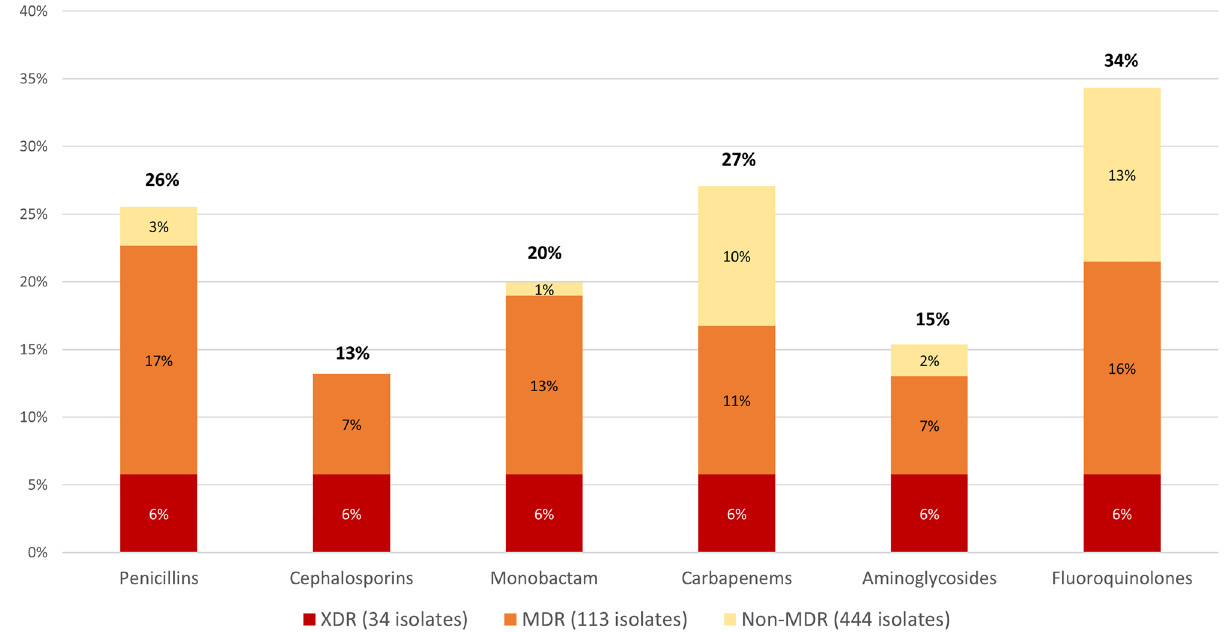
Figure 1. Overall resistance rates of the 591 P. aeruginosa urinary isolates to antimicrobial groups. Overall resistance rates are presented for each antimicrobial group in bold, above the bar chart. Percentage of non- MDR (MultiDrug Resistant), MDR, and XDR (eXtensively Drug Resistant) profiles are indicated for each antimicrobial group inside the bar